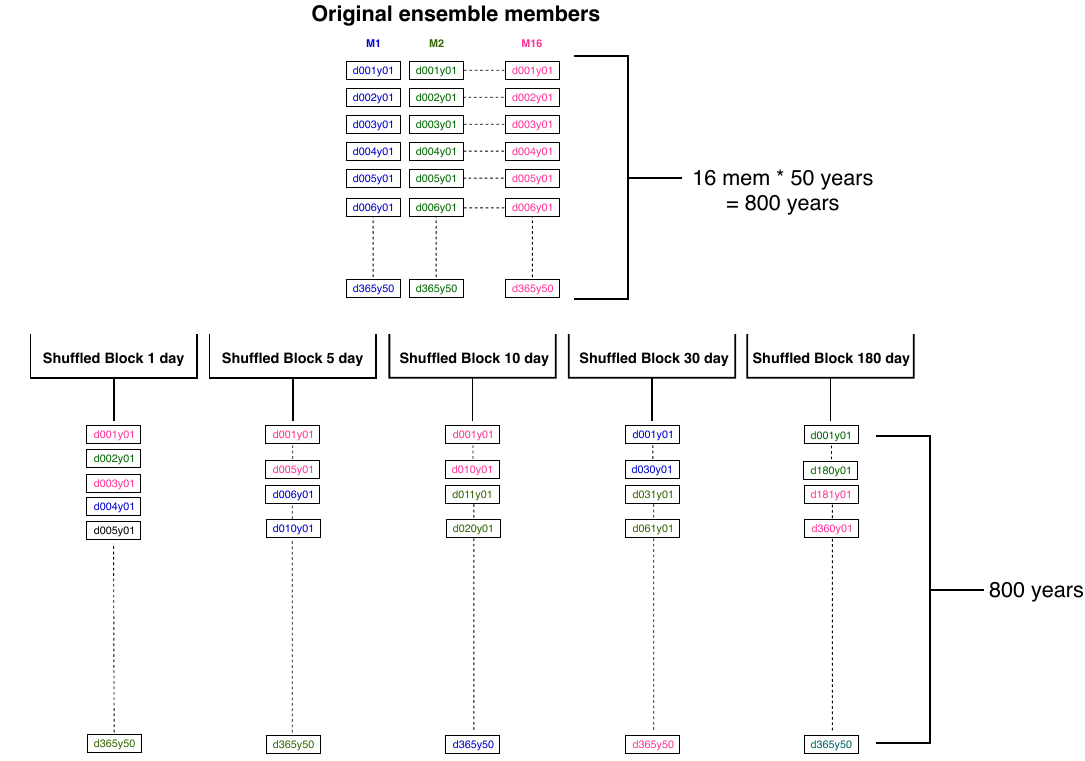
Figure 2. The resampling technique used in the study. ‘d’ stands for the calendar day, ‘y’ stand for the year and ‘M’ stands for the ensemble member number. The color designates the sequences of days kept together as per the block and data from the same ensemble member is used. For instance, in the block of five days, the five days memory is preserved both in temperature and